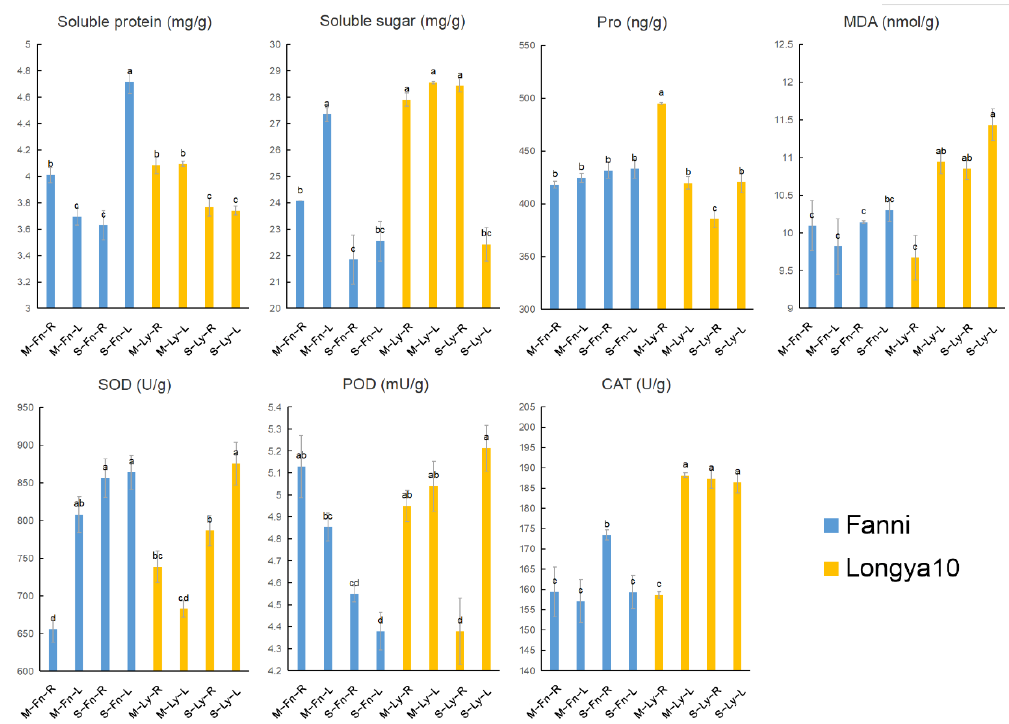
Figure 2. Physiological parameters in the leaf of Fanni and Longya10 under saline stress. The content/activity of the soluble protein, soluble sugar, proline (pro), MDA, SOD, POD, and CAT changes in Fanni and Longya10 under 100 mM NaCl solution for 48 h. M −Fn−R and M −Ly−R represent the root samples derived from Fanni and Longya10 plants, respectively. S −Fn−R and S −Ly−R represent the saline-stress-treated root samples derived from Fanni and Longya10 plants, respectively. M−Fn−L and M−Ly−L represent the leaf samples derived from Fanni and Longya10 plants, respectively. S−Fn−L and S−Ly−L represent the saline -stress-treated leaf samples derived from Fanni and Longya10 plants, respectively. Different letters in the same column represent significant difference ( p < 0.05).